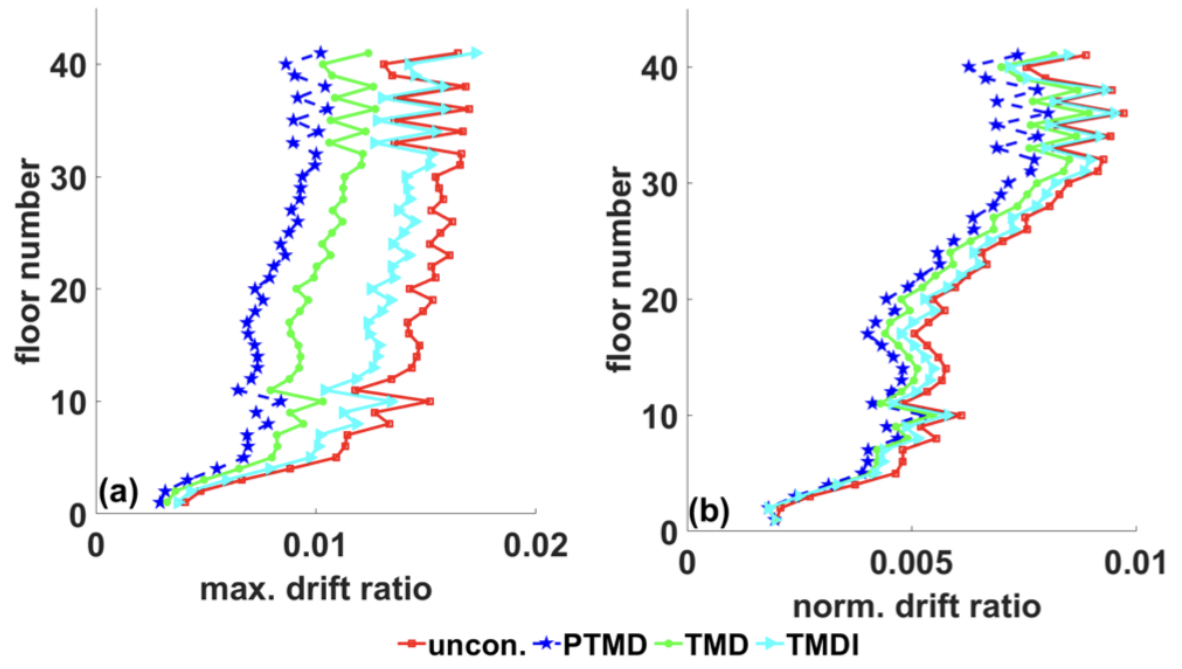
Figure 22. Interstory drift ratio under earthquake: ( a ) peak drift-ratio, ( b ) STD drift-ratio.